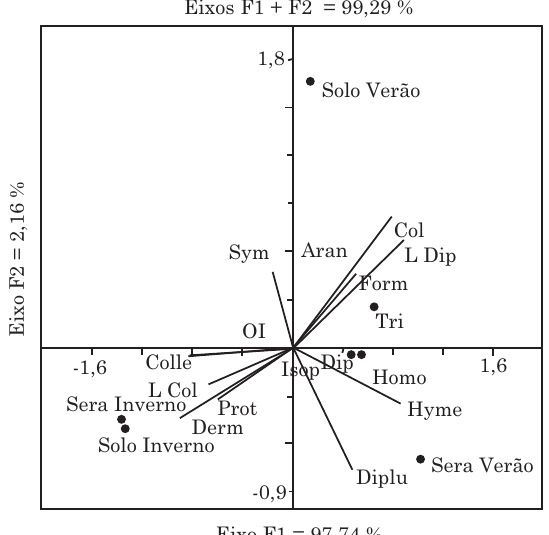
Figura 1. Análise de correspondência canônica para abundância de grupos da fauna do solo nos compartimentos solo e serapilheira (Sera), nas estações verão e inverno na restinga da Marambaia, RJ. OI: outros invertebrados; Diplu: Diplura; Dip: Diptera; Colle: Collembola; L: Larva; Derm: Dermaptera; Isop: Isoptera; Homo: Homoptera; Hyme: Hymenoptera; Symphyla; Aran: Aranae; Col: Coleoptera; Form: Formicidae; Tri: